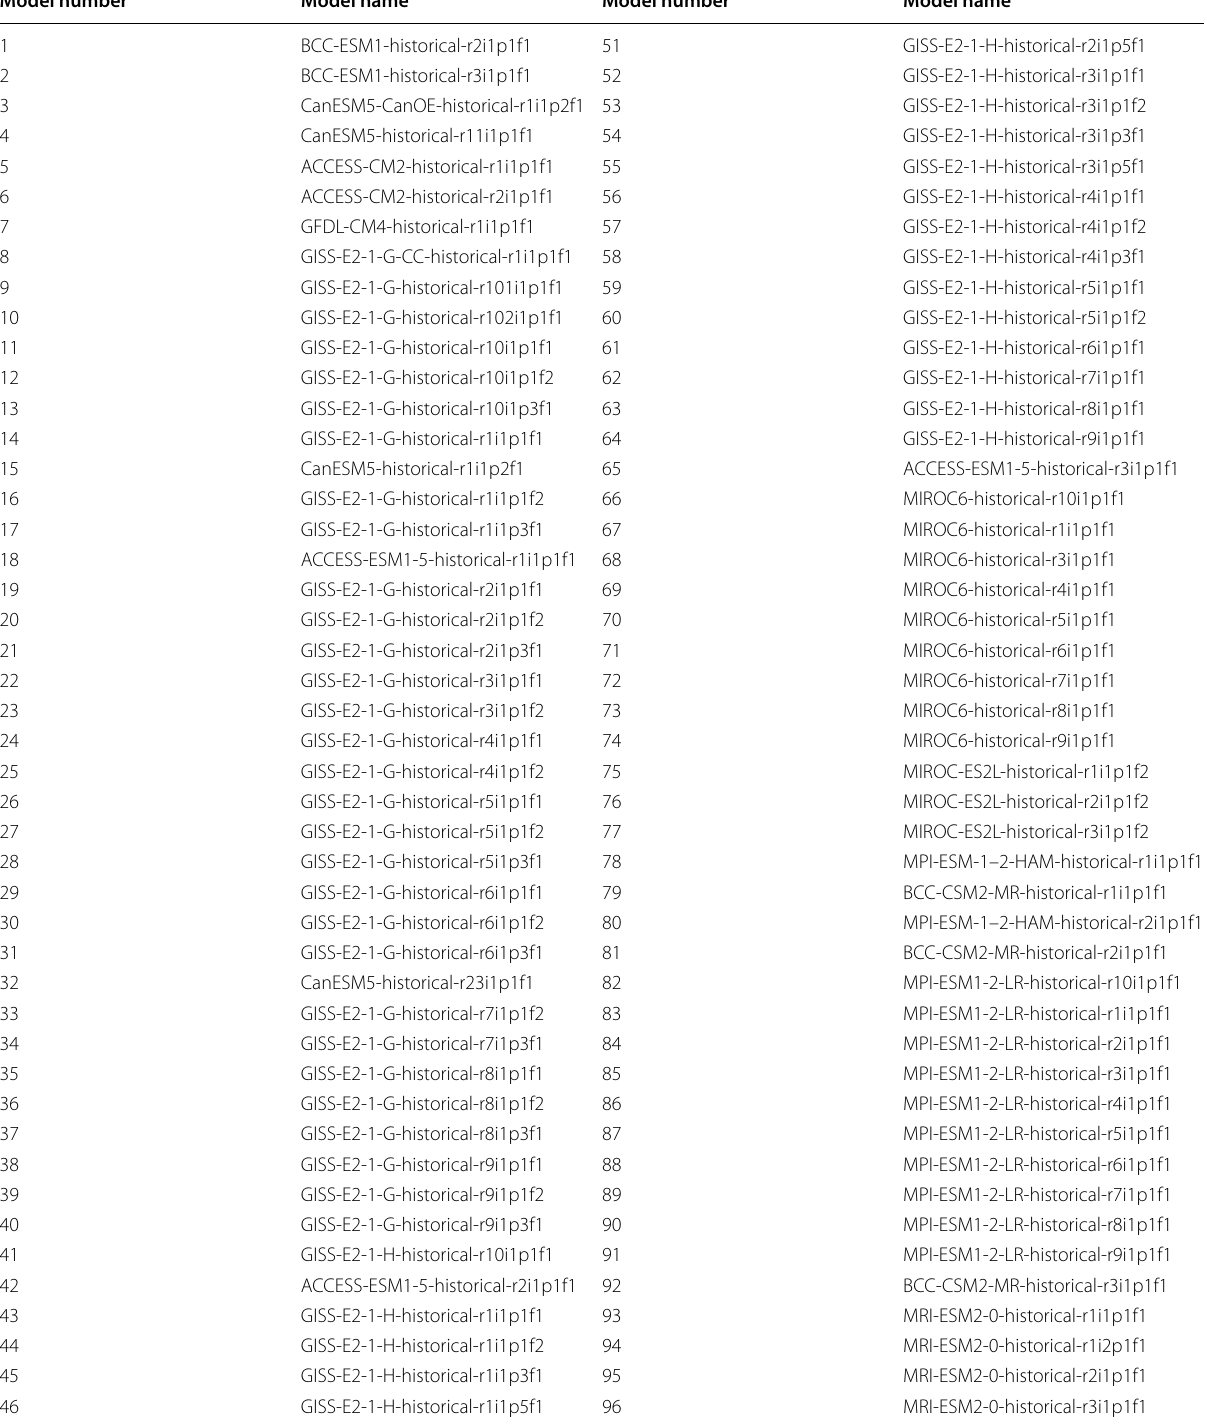
Table 9 List of CMIP6 models used in this study and their numbers corresponding those used in Figs. 2, 6, 7, 10,